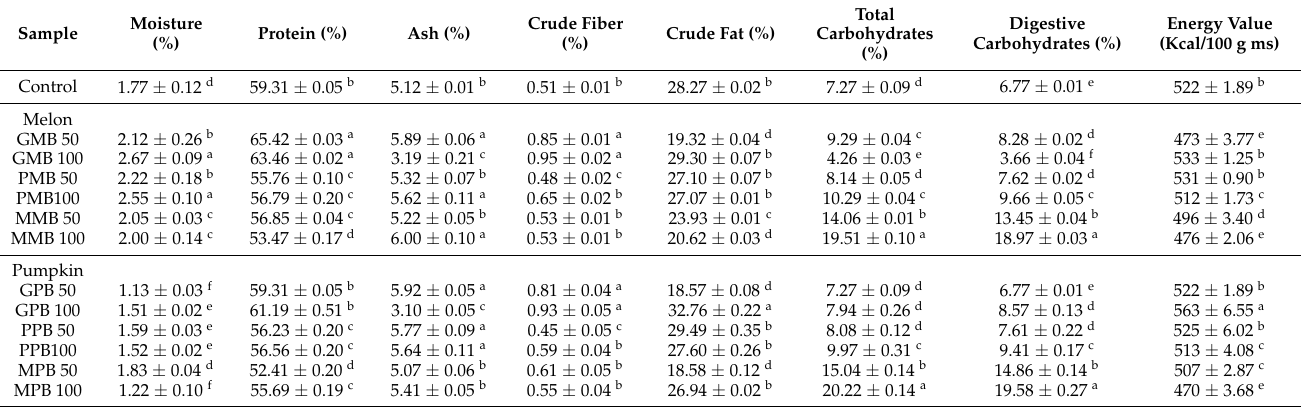
Table 5. Proximate composition of the cooked burgers elaborated with melon and pumpkin